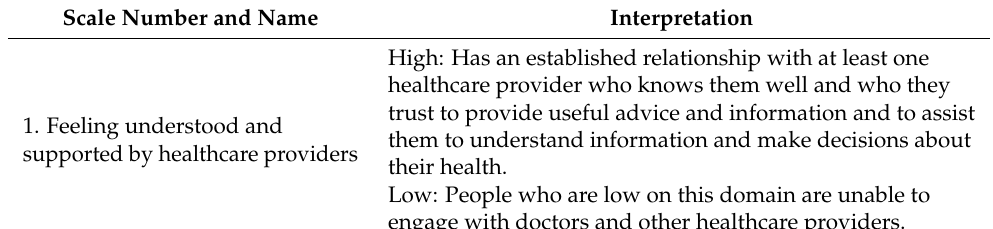
Table 1. Health Literacy Questionnaire scales and